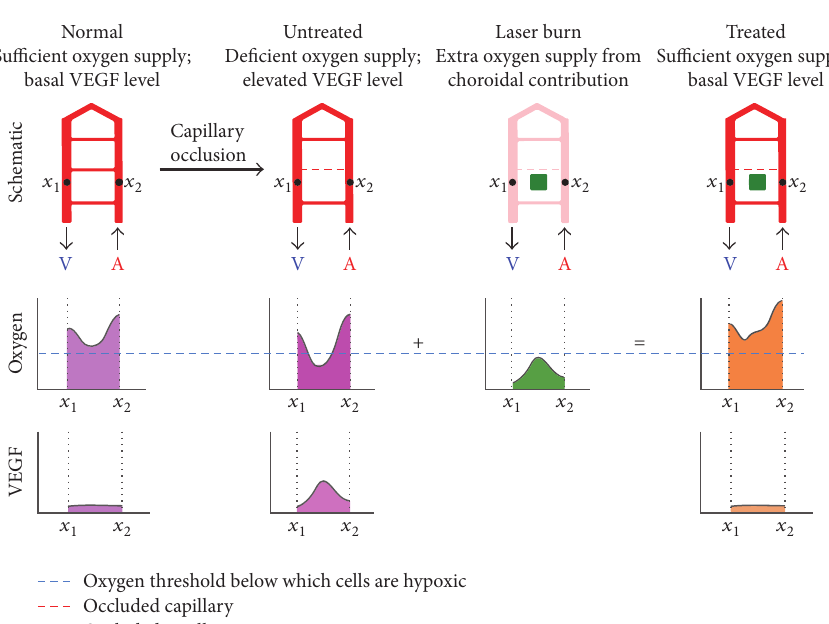
Figure 6: Oxygen and VEGF landscape shift following photocoagulation. Oxygen landscape shift after photocoagulation. The oxygen landscape exhibits peak tension near the arteriole and venule and trough tension near the center between these major vessels (left). Prior to capillary occlusion cells situated at the trough of oxygen tension are only slightly above the hypoxic threshold. Following capillary occlusion, the next subfigure shows the cells now fall below the hypoxia threshold and locally secrete VEGF and other factors propagating nearby capillary occlusion. Photocoagulation therapy, namely, the shortened band pattern therapy shown in the next subfigure as a green block, produces an extra oxygen peak at the center between the arteriole and venule. The additive oxygen tension from the choroid then relieves hypoxia, preventing elevation of VEGF synthesis and protecting against propagation of retinal capillary